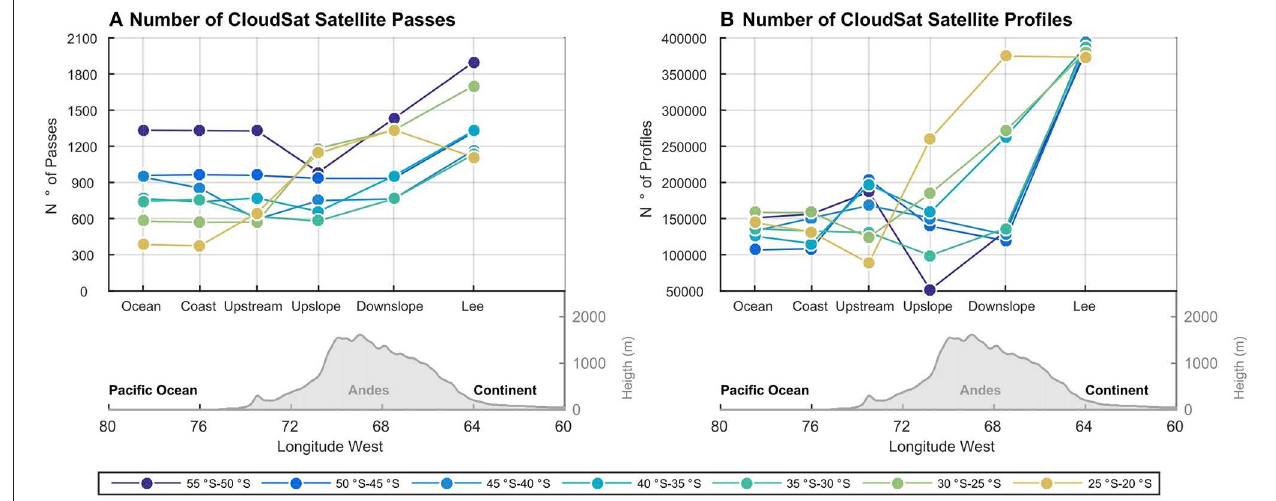
FIGURE 2 | Number of CloudSat satellite (A) passes and (B) pixels over different cross-barrier zones (displayed in x-axes) and different 5 ◦ -width latitudinal bands (i.e., color coded) during the period 2006–2016. The meridional-averaged cross-sections of the Andes elevations between 20 and 55 ◦ S are plotted below each panel for reference. See Figure 1A for two swaths of the CloudSat satellite passing over the studied region.